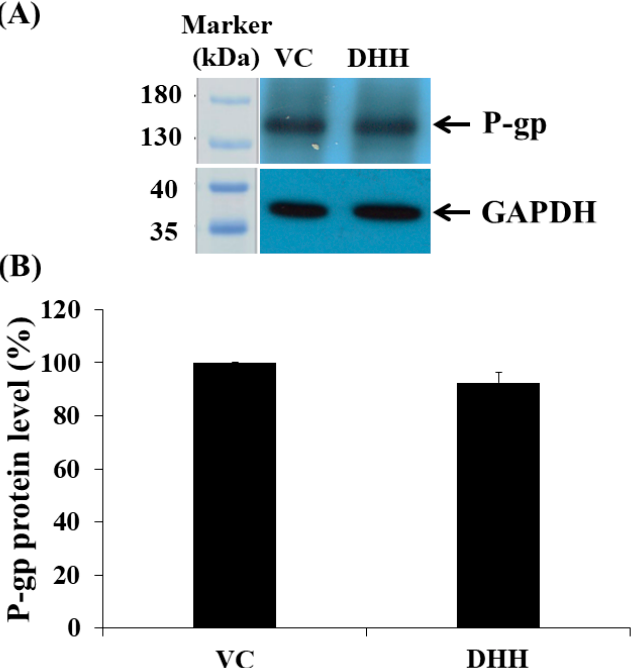
Figure 4. Effect of DHH on the P-gp expression in K562/ADR cells. K562/ADR cells were cultured with DHH at the IC 20 value (55.6 µM) for 48 h. The P-gp level was determined by Western blotting using ( A ) rabbit monoclonal anti-P-gp IgG and ( B ) quantified by densitometry. Glyceraldehyde phosphate dehydrogenase (GAPDH) was used to normalize the level of P-gp. Data represent mean ± SD of three dependent experiments. The significance of mean differences was assessed using one-way